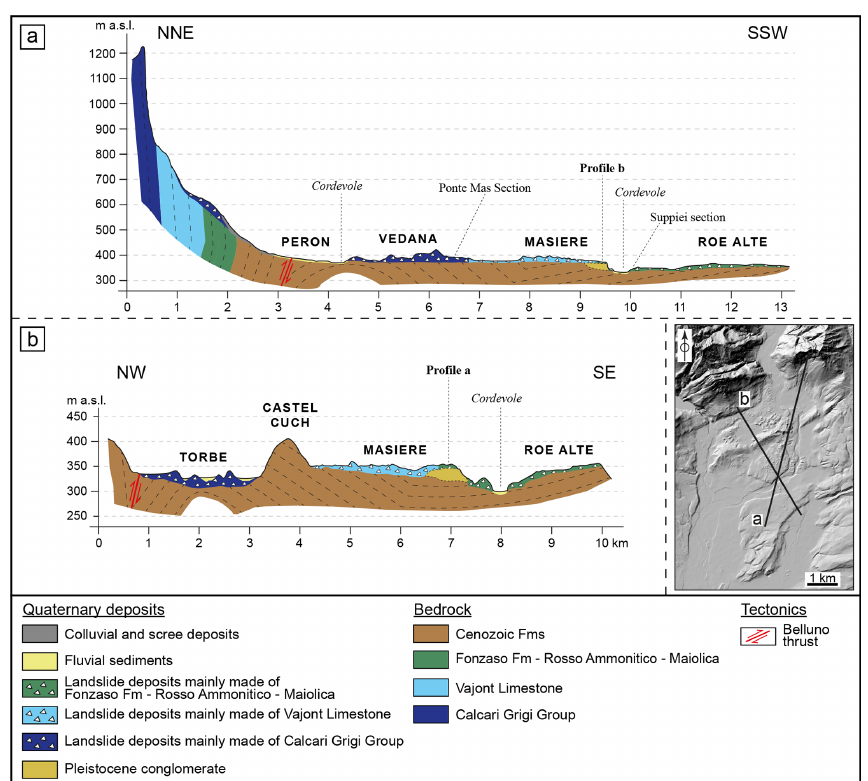
Figure 4. Geologic profiles of the Mt. Peron rock avalanche deposits (modified from Costa et al., 1996). Traces of the profiles are shown in the small DTM and in Fig. 3a, their extent being equal. The discussed sectors of the Mt. Peron rock avalanche, Vedana, Torbe, Masiere and Roe Alte, are indicated, along with the location of Ponte Mas and Suppiei stratigraphic sections (Fig. 5g and h). The vertical bedding and interpreted Belluno thrust are shown schematically. Note the preservation of bedrock stratigraphic order in the rock avalanche deposits from older to younger, i.e. from proximal to distal: Calcari Grigi Group, Vajont Limestone, Fonzaso Formation–Rosso